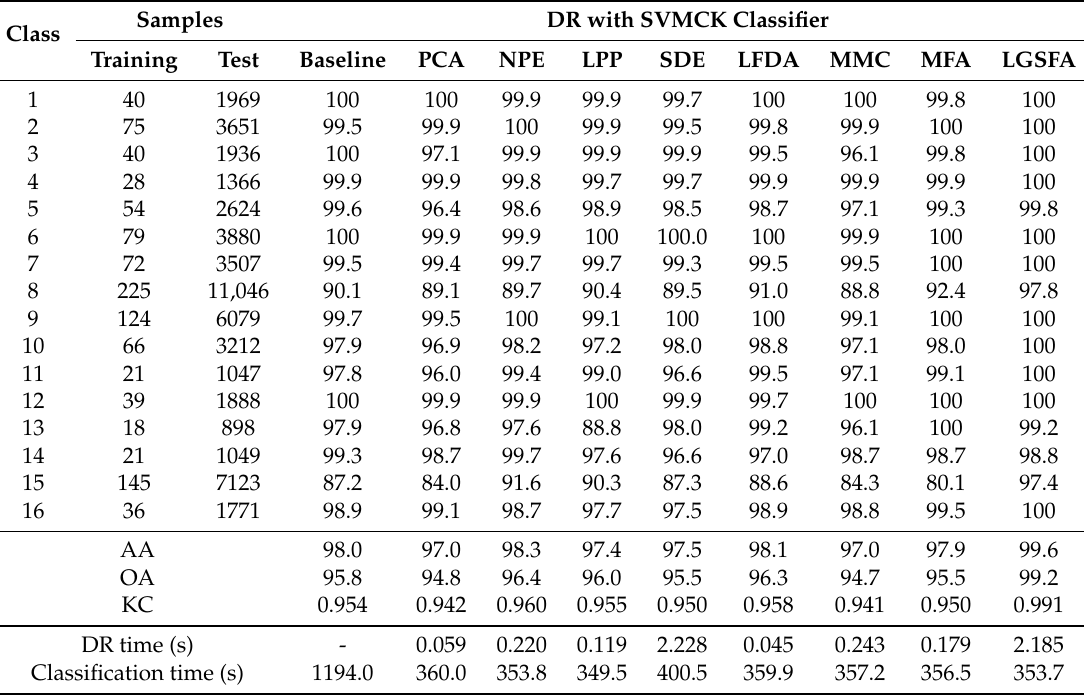
Table 2. Classification results of different DR methods with SVMCK on the Salinas data set.